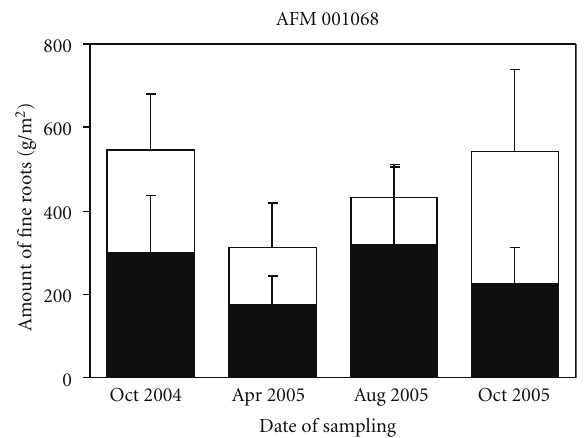
Figure 2: The amount of live (unfilled bar) and dead (black bar) fine roots ( < 1mm in diameter) on the four sampling occasions in the coniferous fern site at Forsmark during 2004-2005. Mean values ±